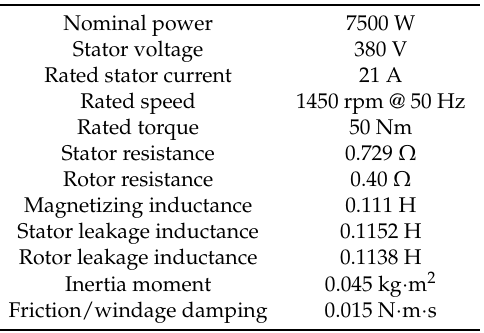
Table A1. Ratings and parameters of the SCIG.